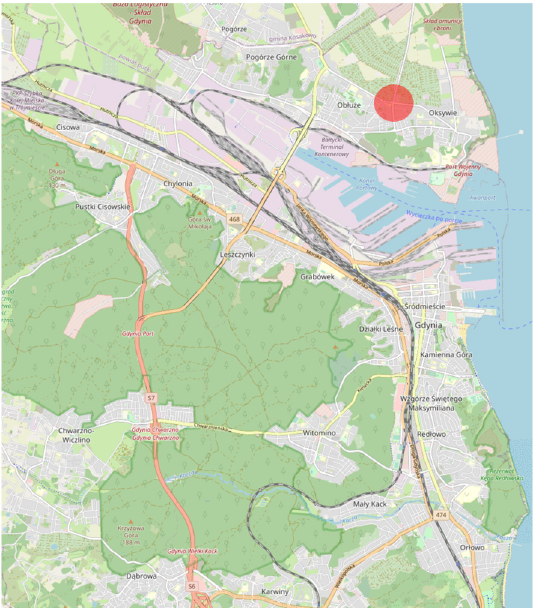
Figure 2. Location of the intersection (marked with a red circle) in the city